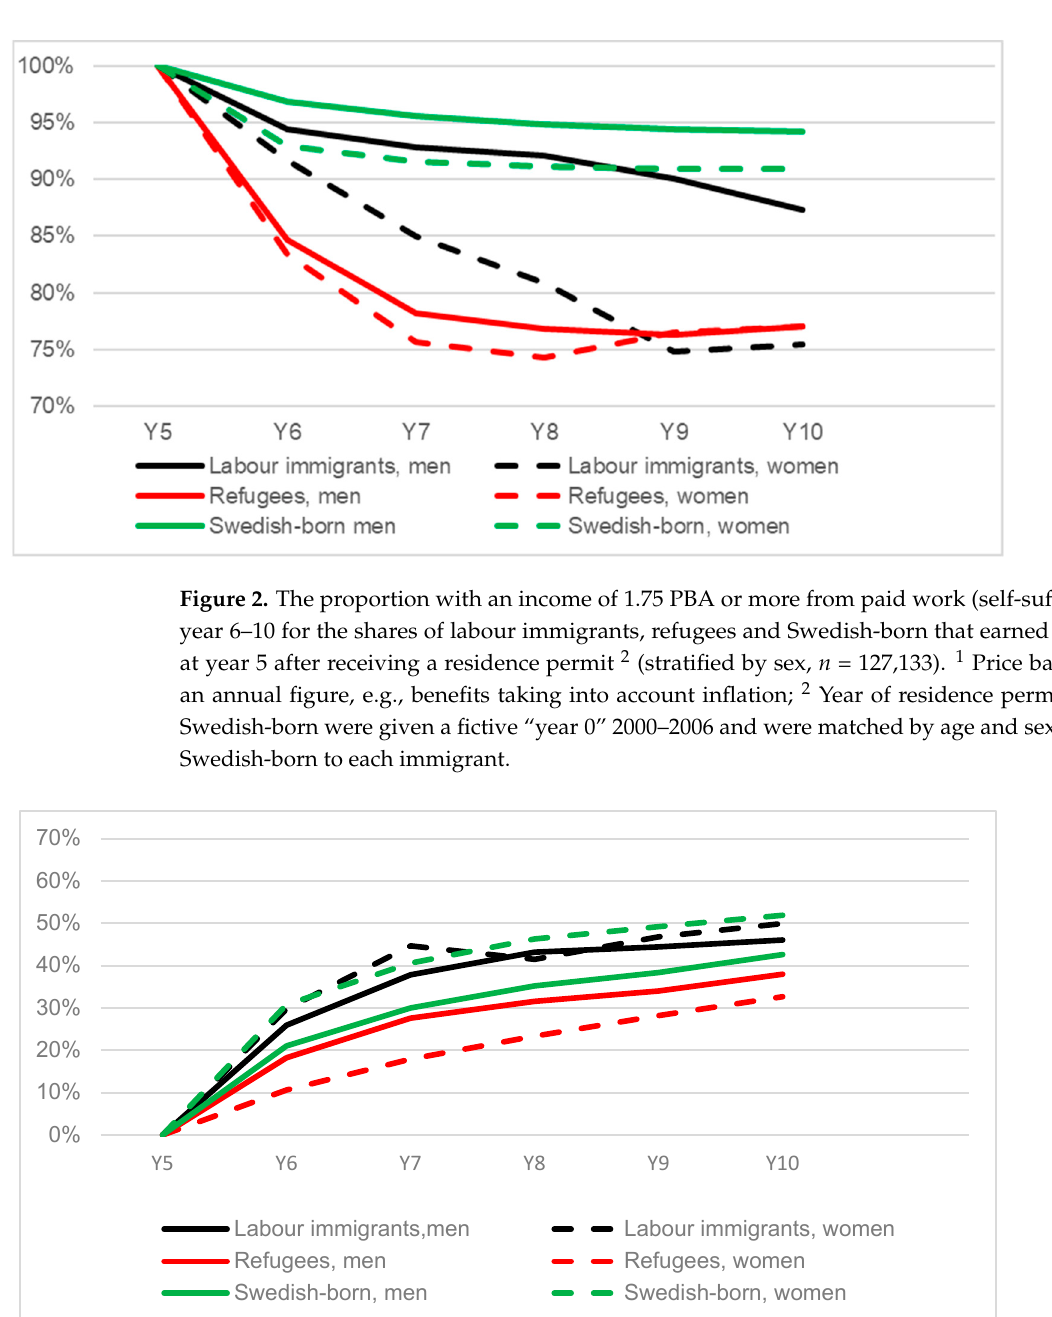
Figure 3. Proportion with an income of 1.75 PBA or more from paid work (self-sufficiency) during years 6–10 for the shares of labour immigrants, refugees and Swedish-born who earned less than 1.75 PBA 1 at year 5 after receiving a residence permit 2 (stratified by sex, n = 42 730). 1 Price base amount, an annual figure, e.g., benefits taking into account inflation; 2 Year of residence permit = year 0. Swedish-born were given a fictive “year 0” 2000–2006 and were matched by age and sex; approx. 5 Swedish-born to each immigrant.